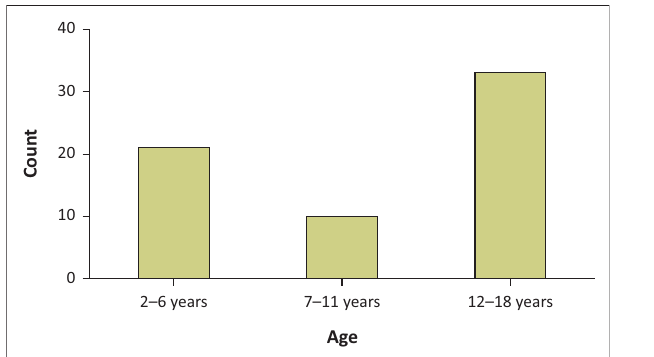
FIGURE 1: Distribution of respondents’ responses on age.